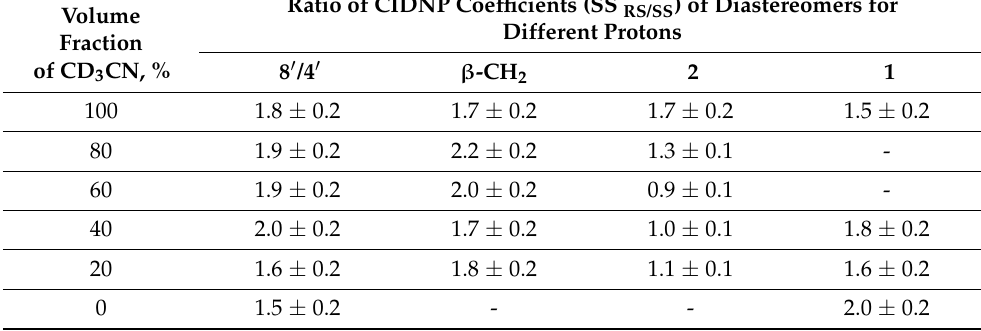
Table 4. SS values measured for protons of dyad I in different mixtures of CD 3 CN/C 6 D 6 [20].